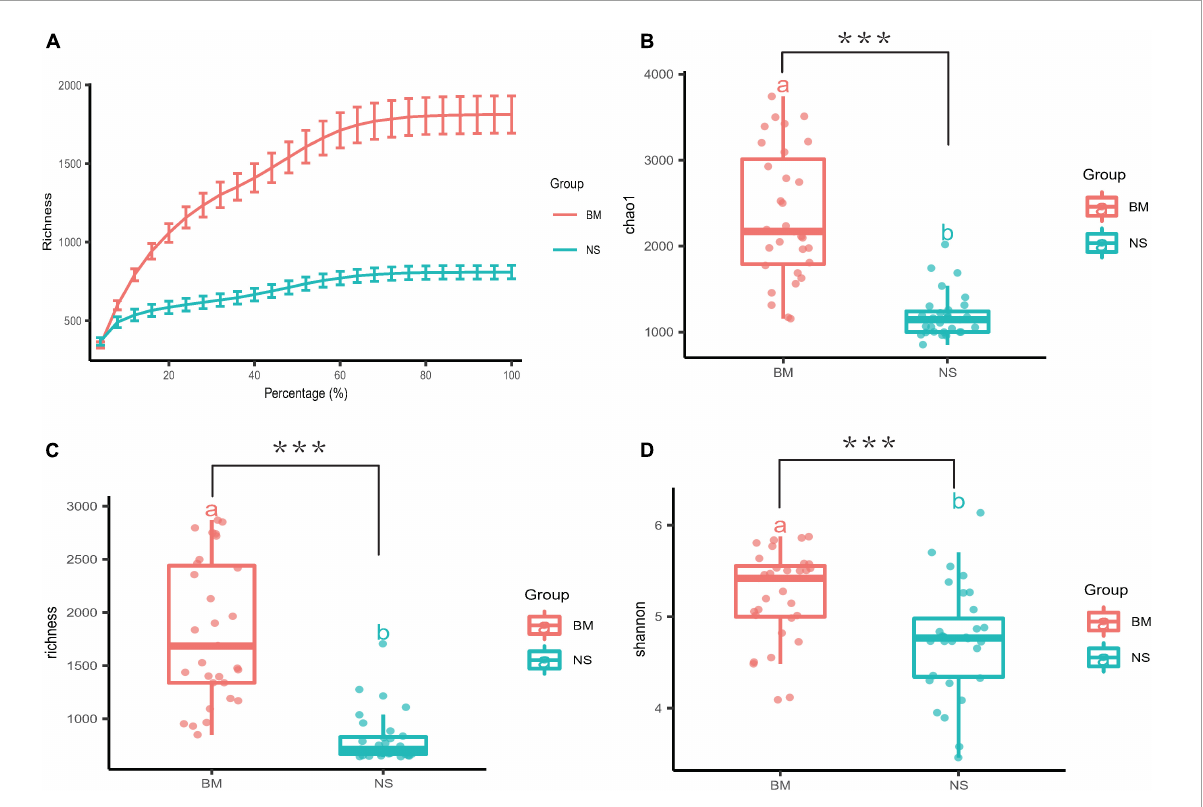
FIGURE1 Measures of α diversity for BM and NS. (A) A rarefaction curve was used to evaluate the sequencing saturation of the samples, and it showed the mean value and standard error of the sequencing depth and the quantity of OTUs. The smoothing of the curves indicated that the sequencing was saturated. (B–D) Box plots of three different α diversity measures: Chao1, richness, and Shannon. The three indices were based on OTUs clustered at 97% similarity for the BM and NS samples (BM, n = 31 vs. NS, n = 31). There were significant differences in Chao1, richness, and Shannon between BM and NS groups (a and b above boxes represent statistical differences) with FDR-adjusted p = 0.000, 0.001, and 0.001 with LSD t -test, respectively. Each scatter represents a sample. The horizontal bars within boxes represent the median, and the tops and bottoms of the boxes represent the 75th and 25th quartiles, respectively. *** p ≤